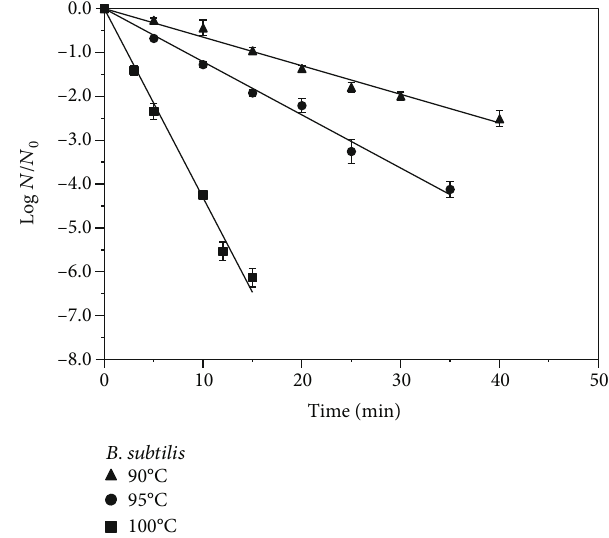
Figure 3: Heat inactivation of Bacillus subtilis spores in guava juice (11.4 ° Brix, pH4.1) at 90 ° C-100 ° C.